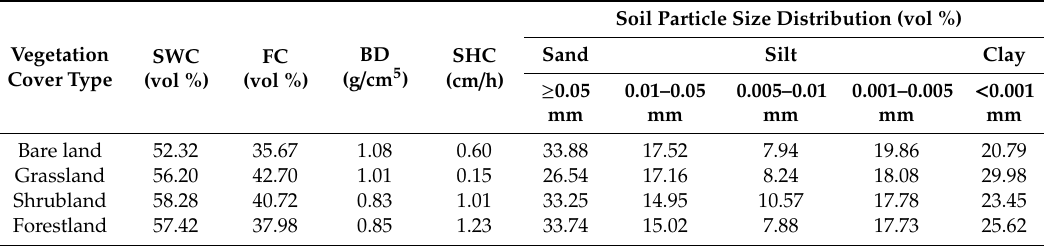
Table 1. Attributes of soil in each